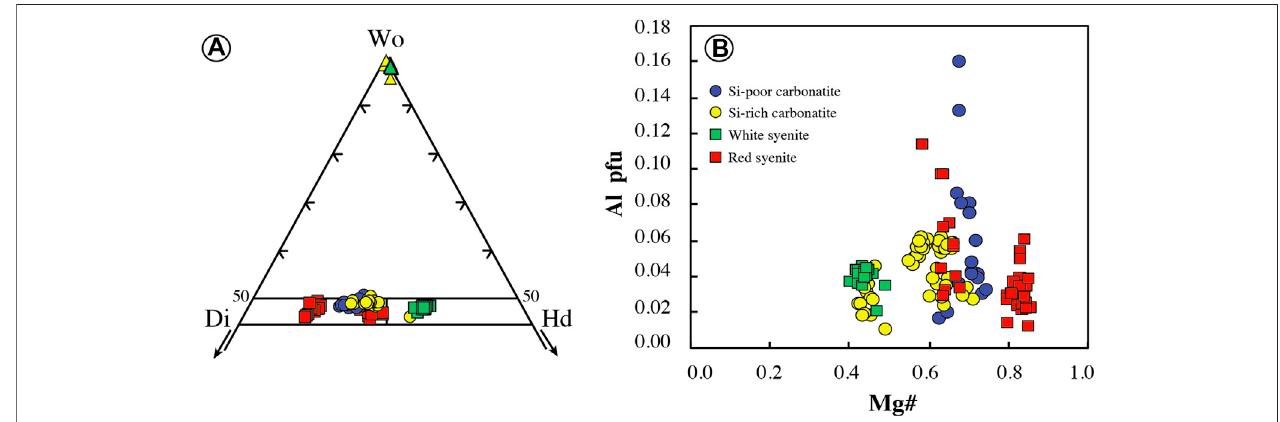
FIGURE 7 | Clinopyroxene mineral chemistry of the Ihouhaouene carbonatites and syenites in molar units. (A) Chemical variation of clinopyroxene and wollastonite (triangles)intheEnstatite(En) – Wollastonite(Wo) – Ferrossilite(Fs)ternarydiagramofMorimoto,(1988). (B) Alvs.Mg#(p.f.u.);Mg# (cid:1) Mg/(Mg+Fe tot ).Symbolsasin Figure4 .